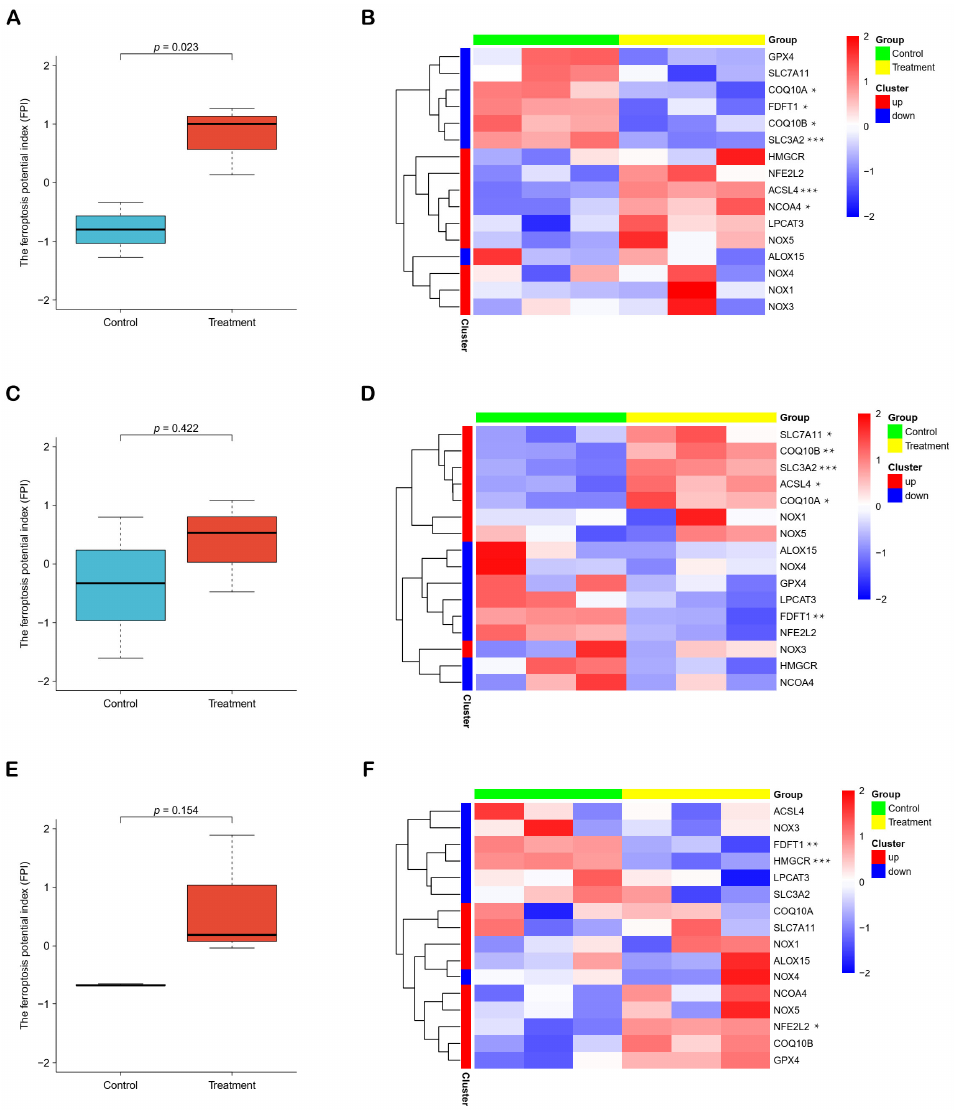
Figure 4. The ferroptosis potential index. ( A , C , E ) Three boxplots showed the levels of ferroptosis in PLC, KMCH and Huh7 cell lines after curcumin treatment, respectively. ( B , D , F ) Three heatmaps showed the expression of genes used to calculate FPI. * p < 0.05. ** p < 0.01. *** p < 0.001.